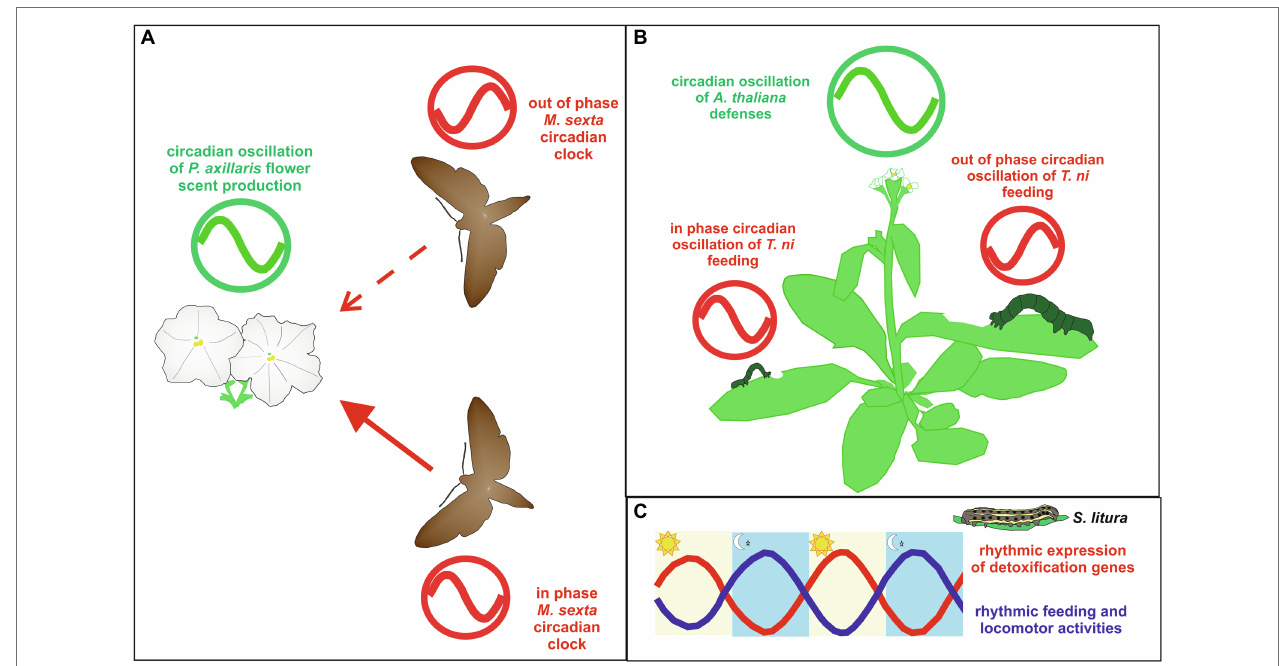
FIGURE 4 | Examples of circadian clock-controlled interactions between Lepidoptera and plants. (A) The interplay between Manduca sexta and Petunia axillaris circadian clocks. Petunia axillaris flower scent production displays a circadian oscillation with a peak during the night (green clock). When M. sexta and P. axillaris clocks are synchronized (in phase), moths show higher levels of flower visits regarding moths with a circadian clock shifted by 12 h compared to the plant clock (out of phase; Fenske et al., 2018). Manduca sexta circadian clocks are indicated in red. Solid and dashed red lines represent the higher and lower number of flower visits, respectively. (B) Trichoplusia ni caterpillars feeding on Arabidopsis thaliana . Arabidopsis thaliana jasmonate-mediated defenses show a circadian oscillation, which peaks during the day (green clock). When T. ni and A. thaliana clocks are synchronized (in phase), caterpillars feed less and, in turn, grow less rapidly compared to caterpillars with an internal clock shifted by 12 h compared to the plant clock (out of phase; Goodspeed et al., 2012). Trichoplusia ni circadian clocks are indicated in red. (C) Schematic representations of the daily oscillations in locomotor and feeding activities (blue line) and expression of detoxification genes (red line) in Spodoptera litura caterpillars. In light/dark (LD) conditions, midguts and fat bodies show a 24 h rhythmic transcription of detoxification genes with a peak during the daytime, when larvae are inactive, do not feed, and show a digestion activity at the highest levels (Zhang et al., 2021; see text for